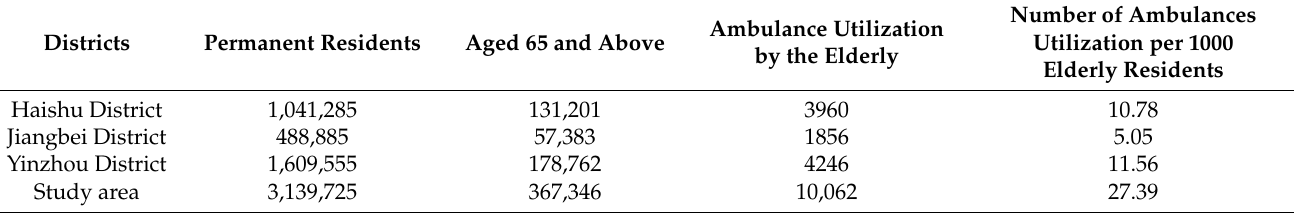
Table 4. The ambulance utilization by the elderly in